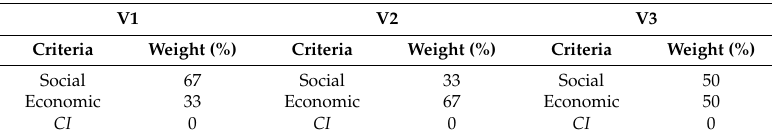
Table 12. Weights of total vulnerability criteria for each scenario.